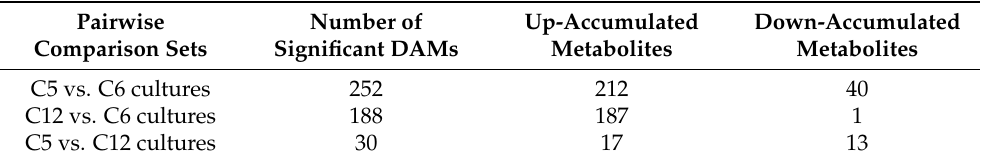
Table 1. The significant differentially accumulated metabolites (DAMs) across three pairwise comparison sets of the cultures using different carbon sources.